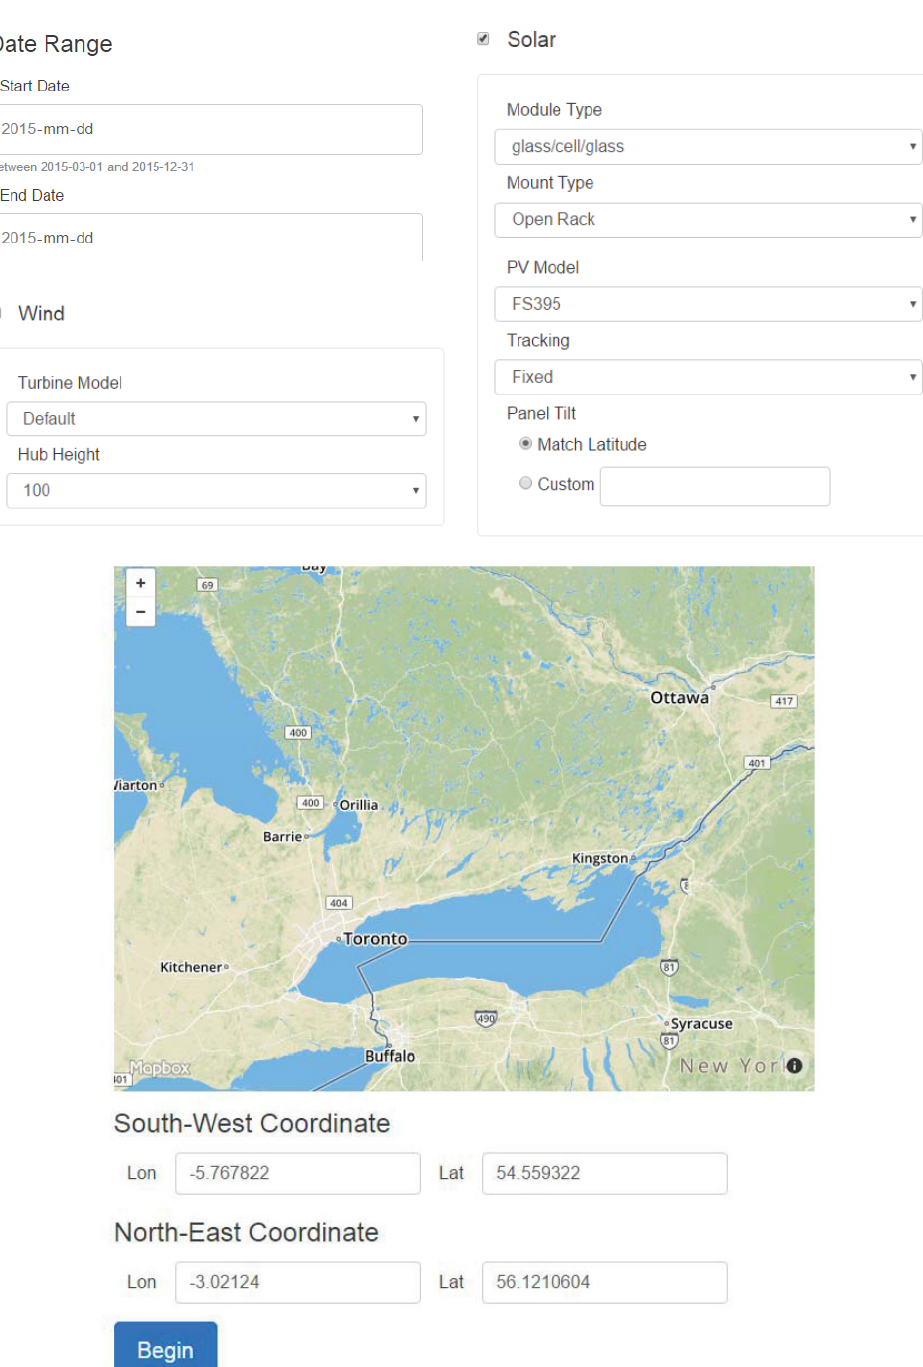
Figure 2. Screenshot of user-input interface.